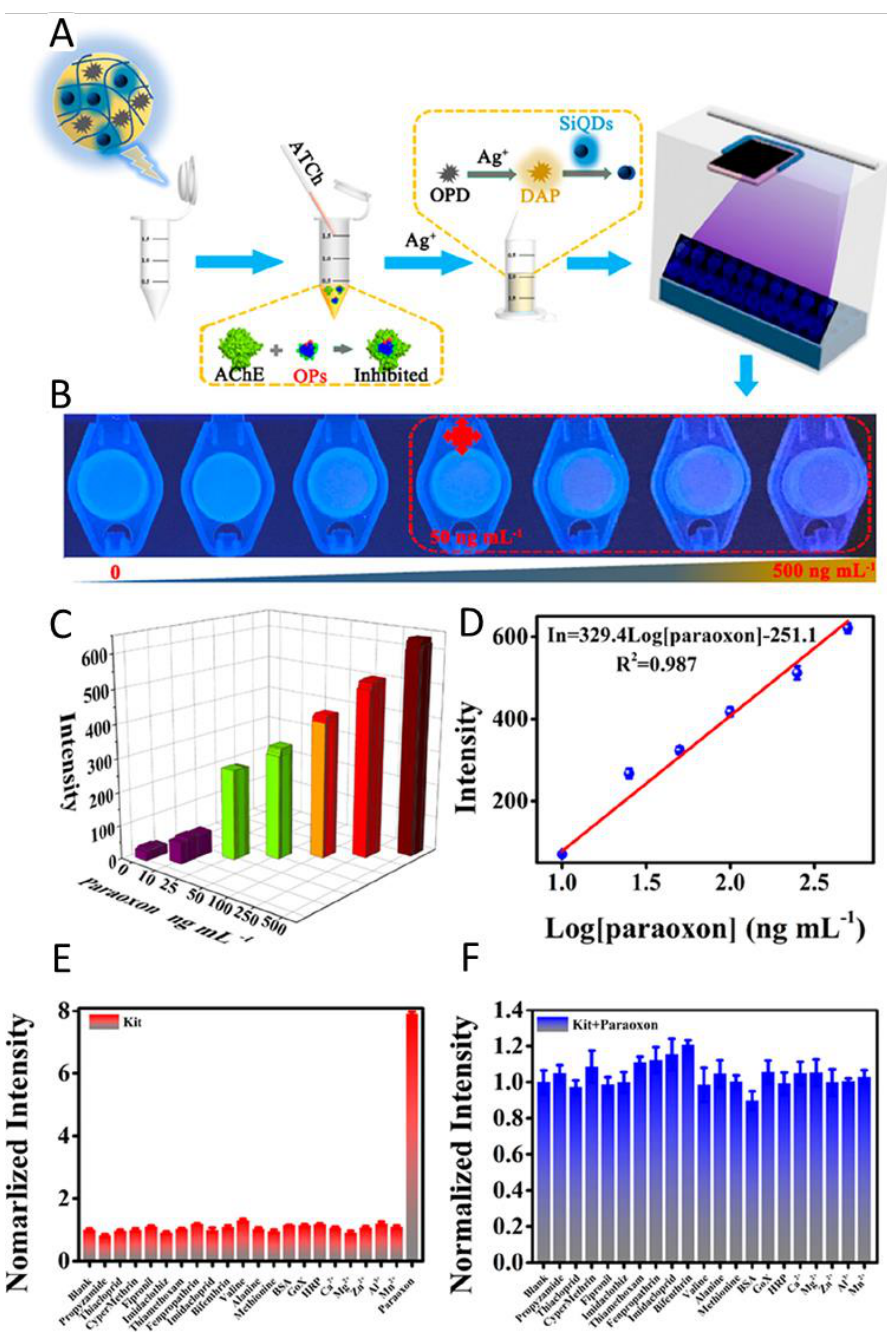
Figure 15. ( A ) Program for detecting OPs. ( B ) Optical images of test kits. ( C ) Original hue intensity of kit digitally analyzed by ImageJ software. ( D ) Relationship between hue intensity and the logarithm of concentration of paraoxon (10, 25, 50, 100, 250, and 50 ng/mL). ( E ) Portable kit in the presence of interfering substances. ( F ) Portable kit for pesticide detection with the coexisting substances. (Reprinted with permission from [182]. Copyright 2019 American Chemical Society).